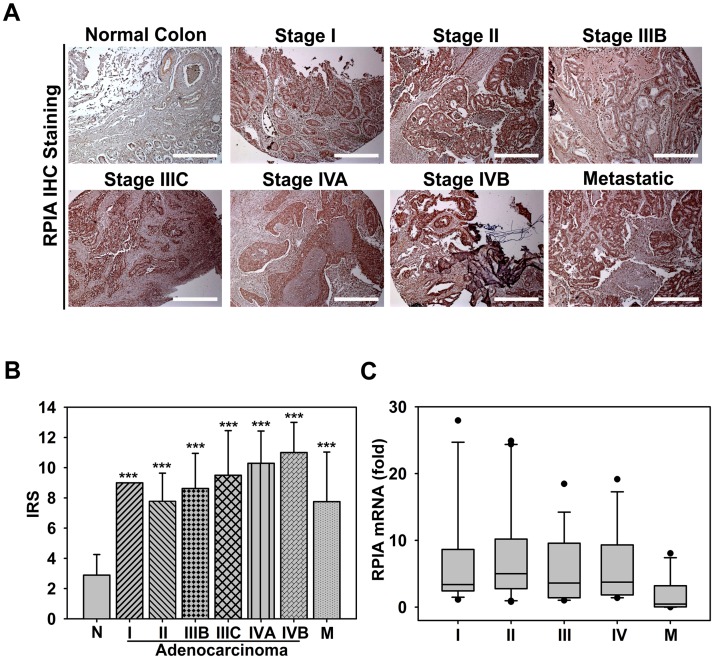
RPIA is highly expressed in different stages of CRC.(A) Representative RPIA IHC staining at different stages of colon cancer is shown. Scale bar: 500 μm. (B) The average IRS for RPIA staining showed significantly increased RPIA expression from stage I to IVB and the M. Stage III was divided into IIIB and IIIC, and stage IV was divided into IVA and IVB based on their subcategories. The statistical significance was calculated with Student t test (*** P < 0.001). (C) The average RPIA mRNA fold change in paired tissues (tumor tissue versus the surrounding normal tissue) from CRC patients at stages I to IV. The box plot indicates the median (central horizontal line), 75th percentile (the top of box), 25th percentile (the bottom of box), maximum value (the top end), minimum value (the bottom end), and the outlier (the point). Data can be found in S1 Data. CRC, colorectal cancer; IHC, immunohistochemistry; IRS, immunoreactive score; M, metastasis stage; N, normal colorectal tissue; RPIA, ribose-5-phosphate isomerase A.